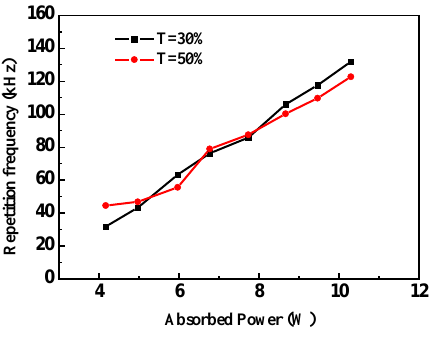
Figure 4. Repetition frequency, as a function of absorbed pump power.